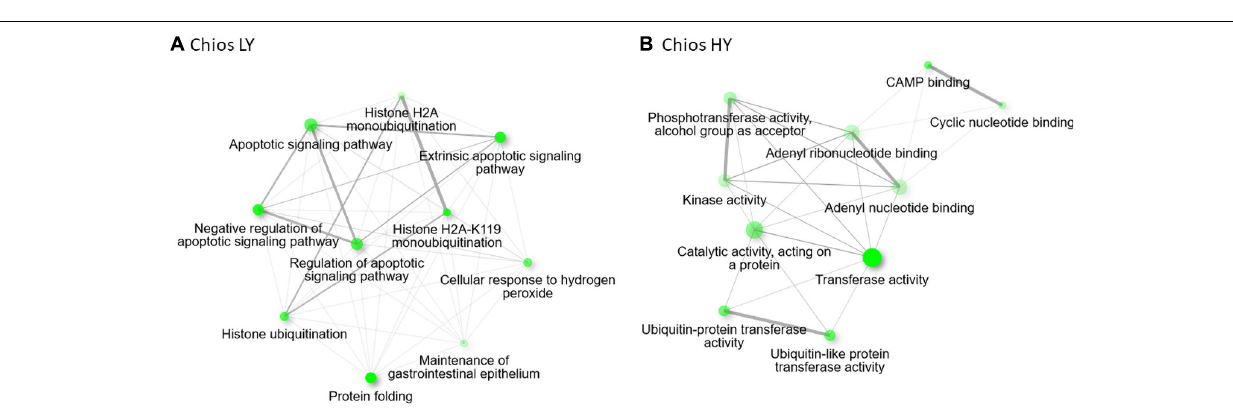
( Figure 5A ). Genes involved in the clusters of the enriched